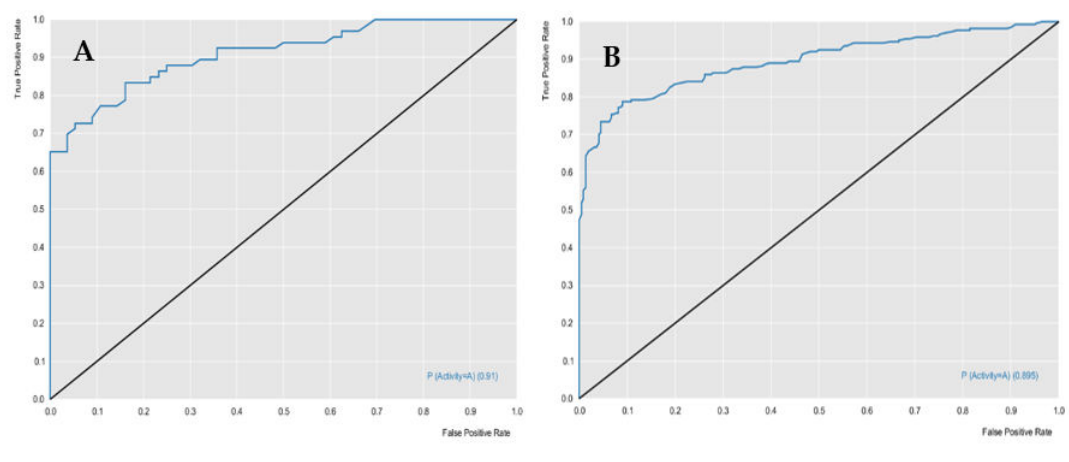
Figure 1. Receiver operating characteristic (ROC) curve generated for the L. major random forest (RF) model. ( A ) Test and ( B ) cross-validation.